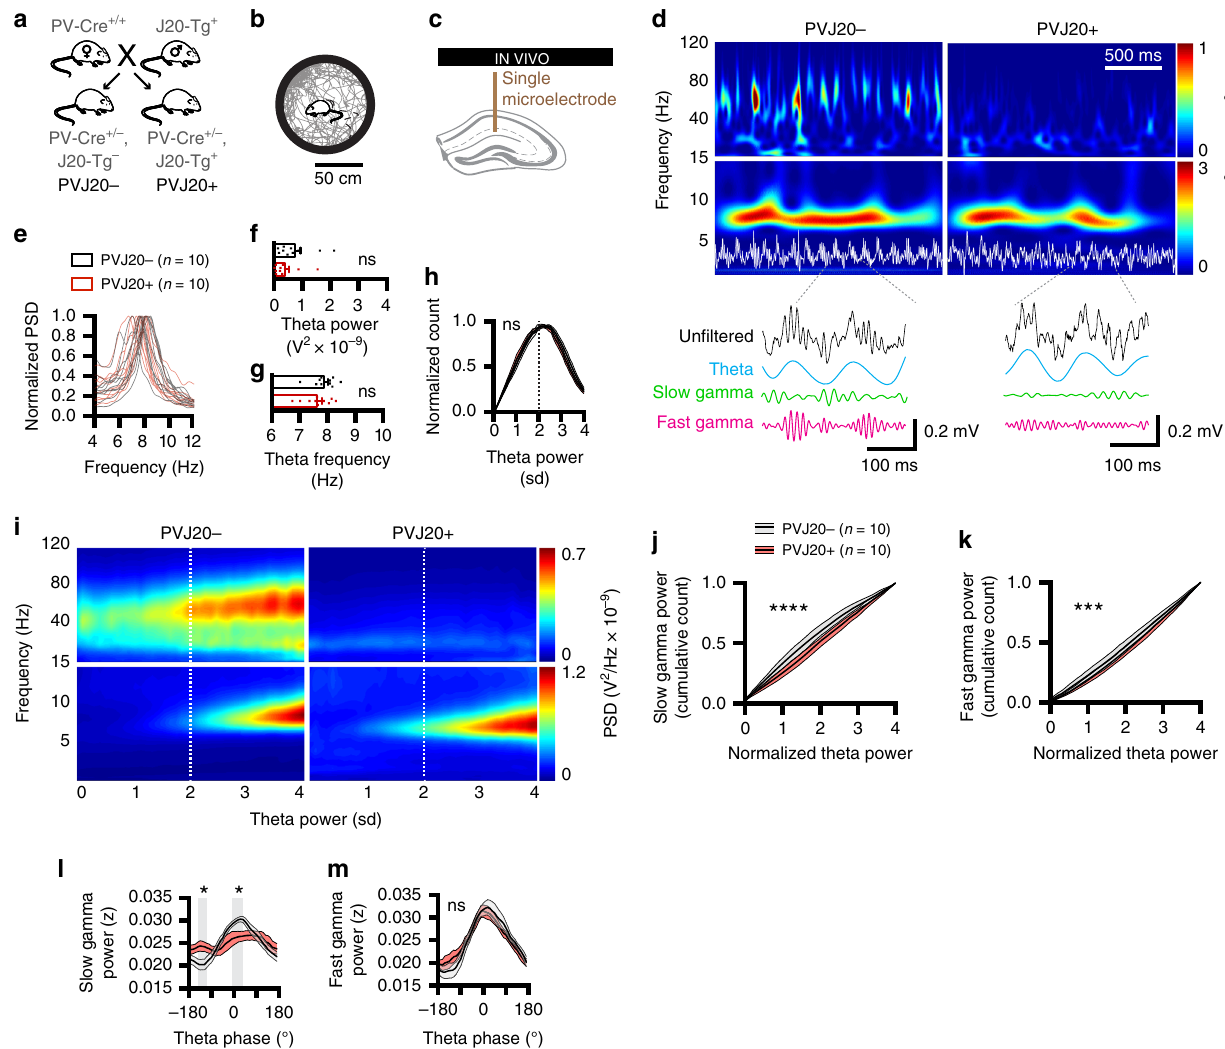
Fig. 1 Altered gamma oscillations in PVJ20 mice. a PVJ20 mouse line breeding scheme. b Exploration trajectory on a circular platform. c Recording con fi guration. d 2 s example spectrograms for PVJ20 − (left) and PVJ20 + (right) mice recorded in CA1-lm while running on the circular plateform. e Normalized power spectra in the theta band for each individual PVJ20 + (red) and PVJ20 − (black) littermates. f Theta power from raw LFP. g Theta peak frequency. h Normalized histogram counts of normalized theta power. i Example spectrograms sorted by normalized theta power from CA1-LFP recorded in PVJ20 − (left) and PVJ20 + (right) mice. j cumulative distribution of slow gamma oscillations. k same for fast gamma. l phase-amplitude coupling of slow gamma power over theta phases. m Same for fast gamma. n = 10 PVJ20 + mice and n = 10 PVJ20 − mice were used in panels e – h , j – m . Color codes in d and i : blue, low power; red, high power. Data expressed as mean ± SEM. ns, not signi fi cant; *, p < 0.05; ***, p < 0.001; ****, p < 0.0001. Test used